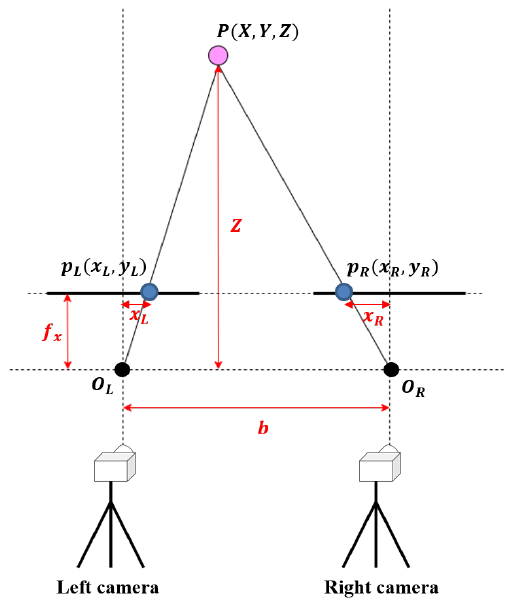
Figure 2. Stereo triangulation approach for estimating the taillight’s world coordinate.